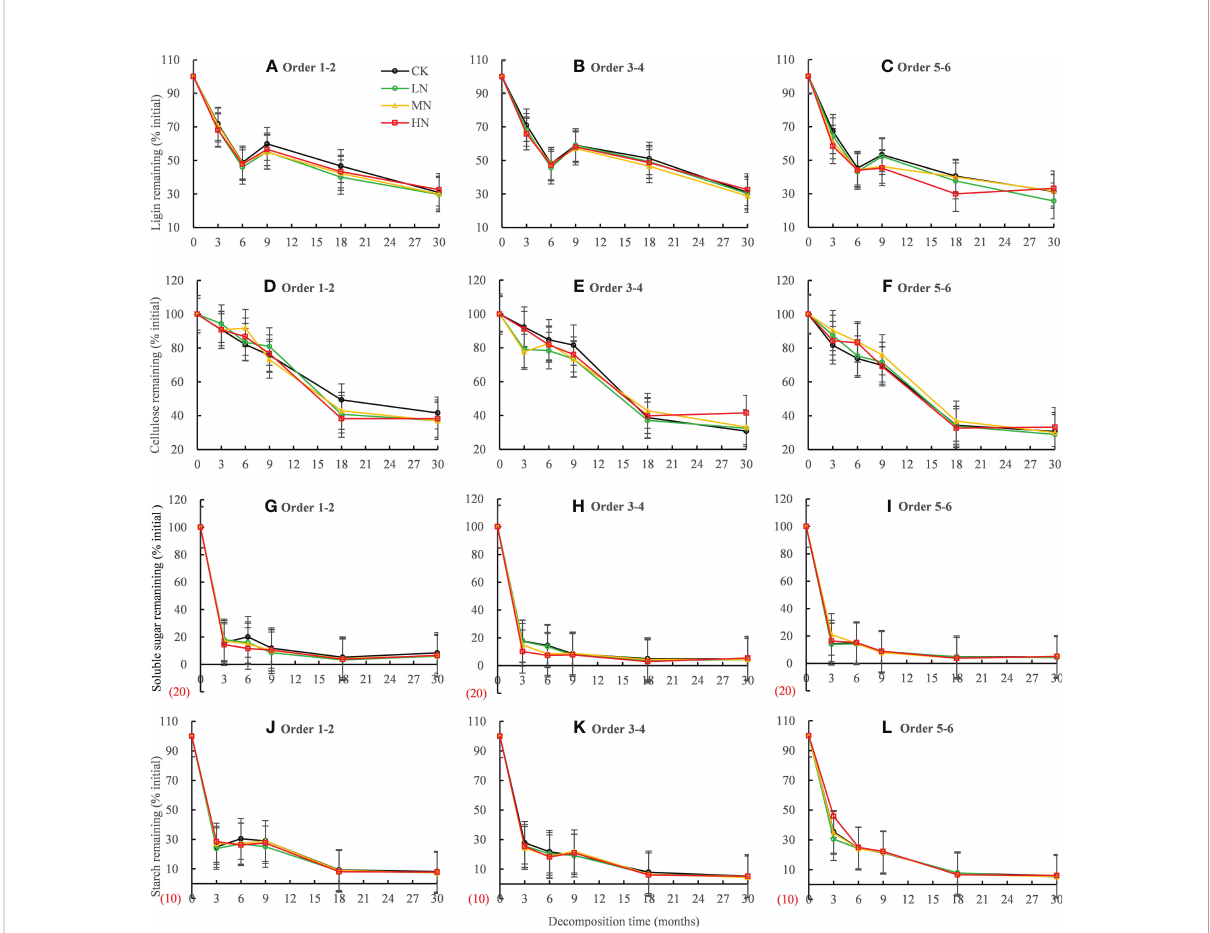
FIGURE 4 Residual percentages of lignin, cellulose, soluble sugar, and starch during the 30-month fi ne root decomposition of Pinus massoniana in different N addition treatments. Values are means ± SE. The different colors denote CK (0 kg ha -1 year -1 ), LN (30 kg ha -1 year -1 ), MN (60 kg ha -1 year -1 ), and HN (90 kg ha -1 year -1 ). (A – L) represent the lignin, cellulose, soluble sugar, and starch remaining in order 1-2, order 3-4 and order 5- 6 fi ne roots,